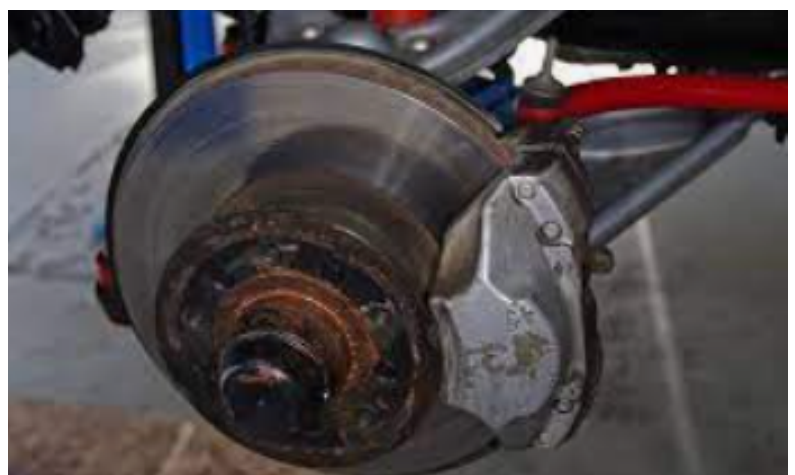
Figure 2. Fuzzy brake control